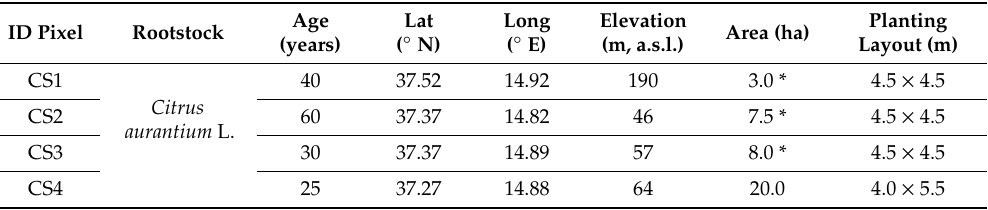
Table 1. Case studies’ (CS) main